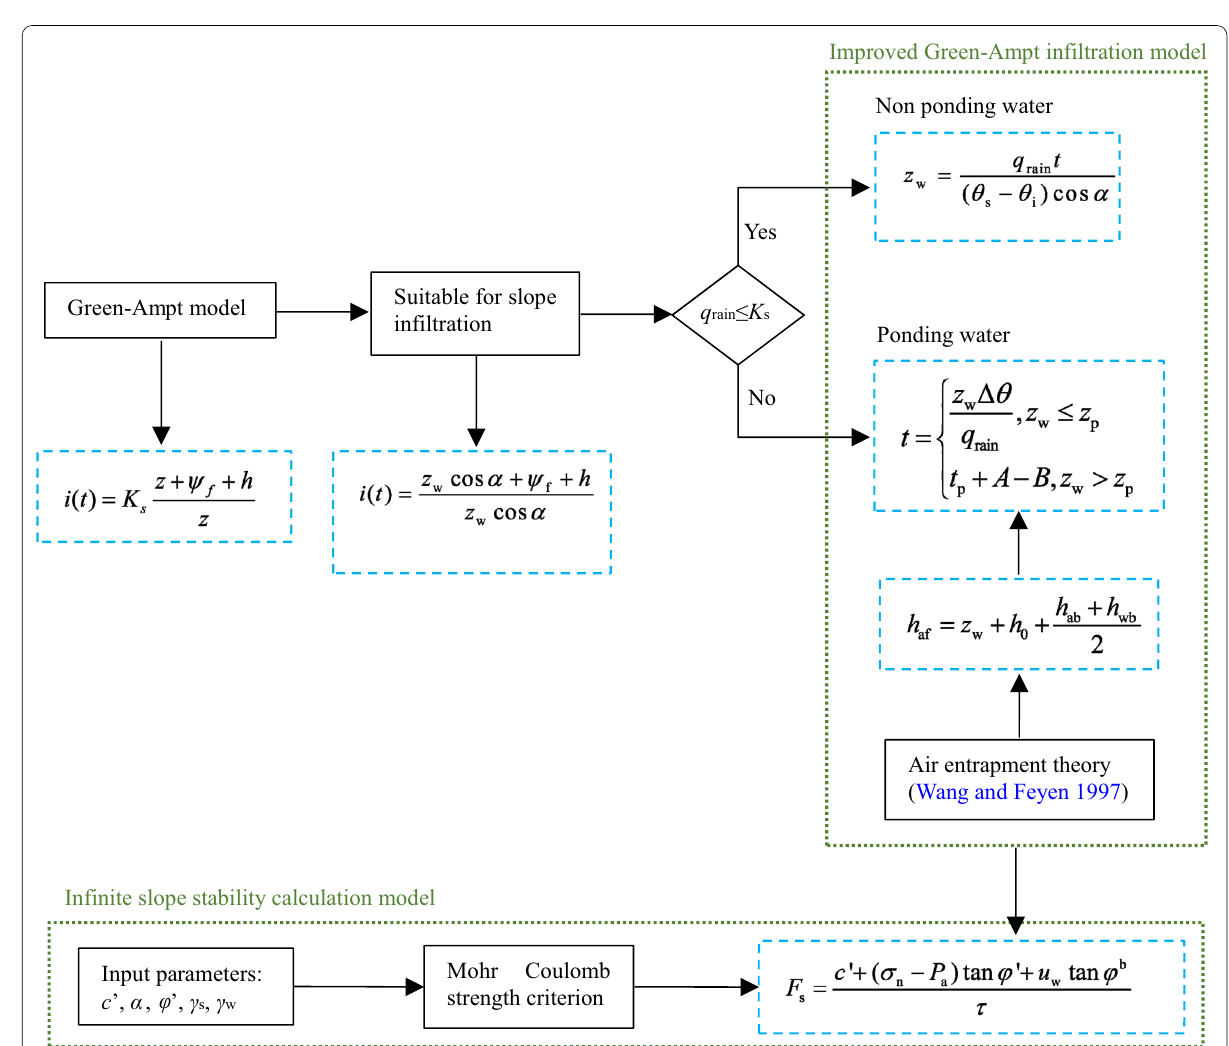
Fig. 2 Calculation flow